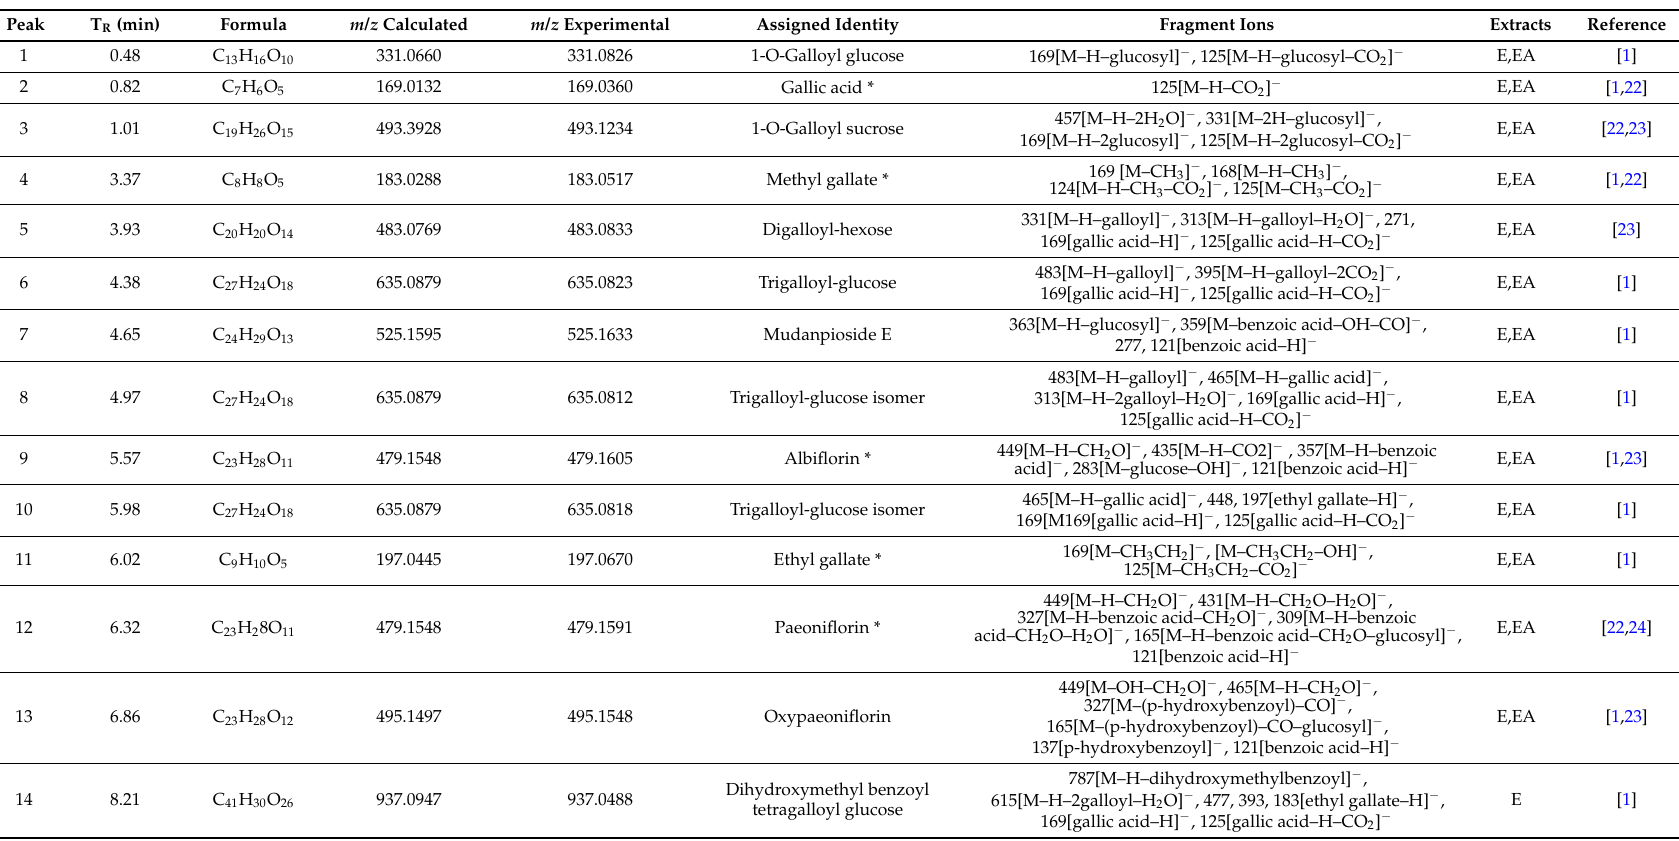
Table 1. Twenty-seven chemical constituents identified in the ethyl acetate fraction (EA) and the ethanol fraction (E) of P. delavayi root extracts using UPLC-Q-TOF-MS.